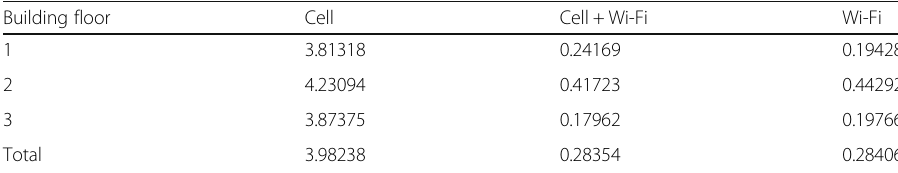
Table 3 The mean distance error of location determination in the first-fold cross validation Building